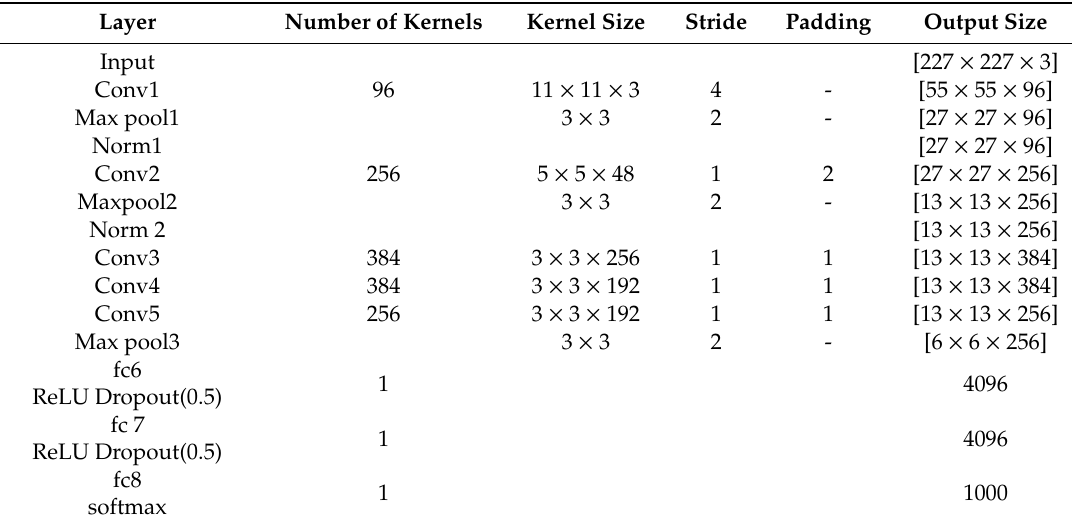
Table 1. Details of AlexNet